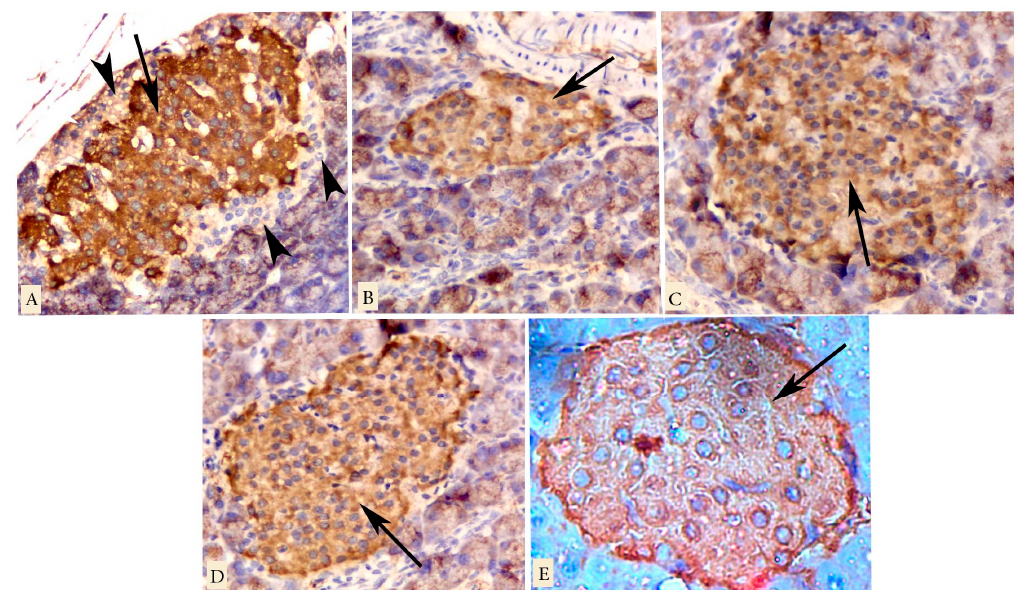
Figure 5. Insulin immunostained photomicrographs of pancreatic islets of the different groups. Arrows mark the brown coloration that is indicative of the positive cytoplasmic reaction. A marked positive reaction is marked in the control group ( A ), in the islet beta cells and surrounded by a peripheral mantle zone of negatively immunostained cells (arrowheads). The shrunken islet, in the untreated diabetic group ( B ), shows a less positive reaction. Sitagliptin-treated ( C ), metformin-treated ( D ), and both-treated ( E ) groups show viable degrees of improvement of insulin immunoreactivity, which is marked in the combined therapy group. Magnification: ( A – E ) ×400.